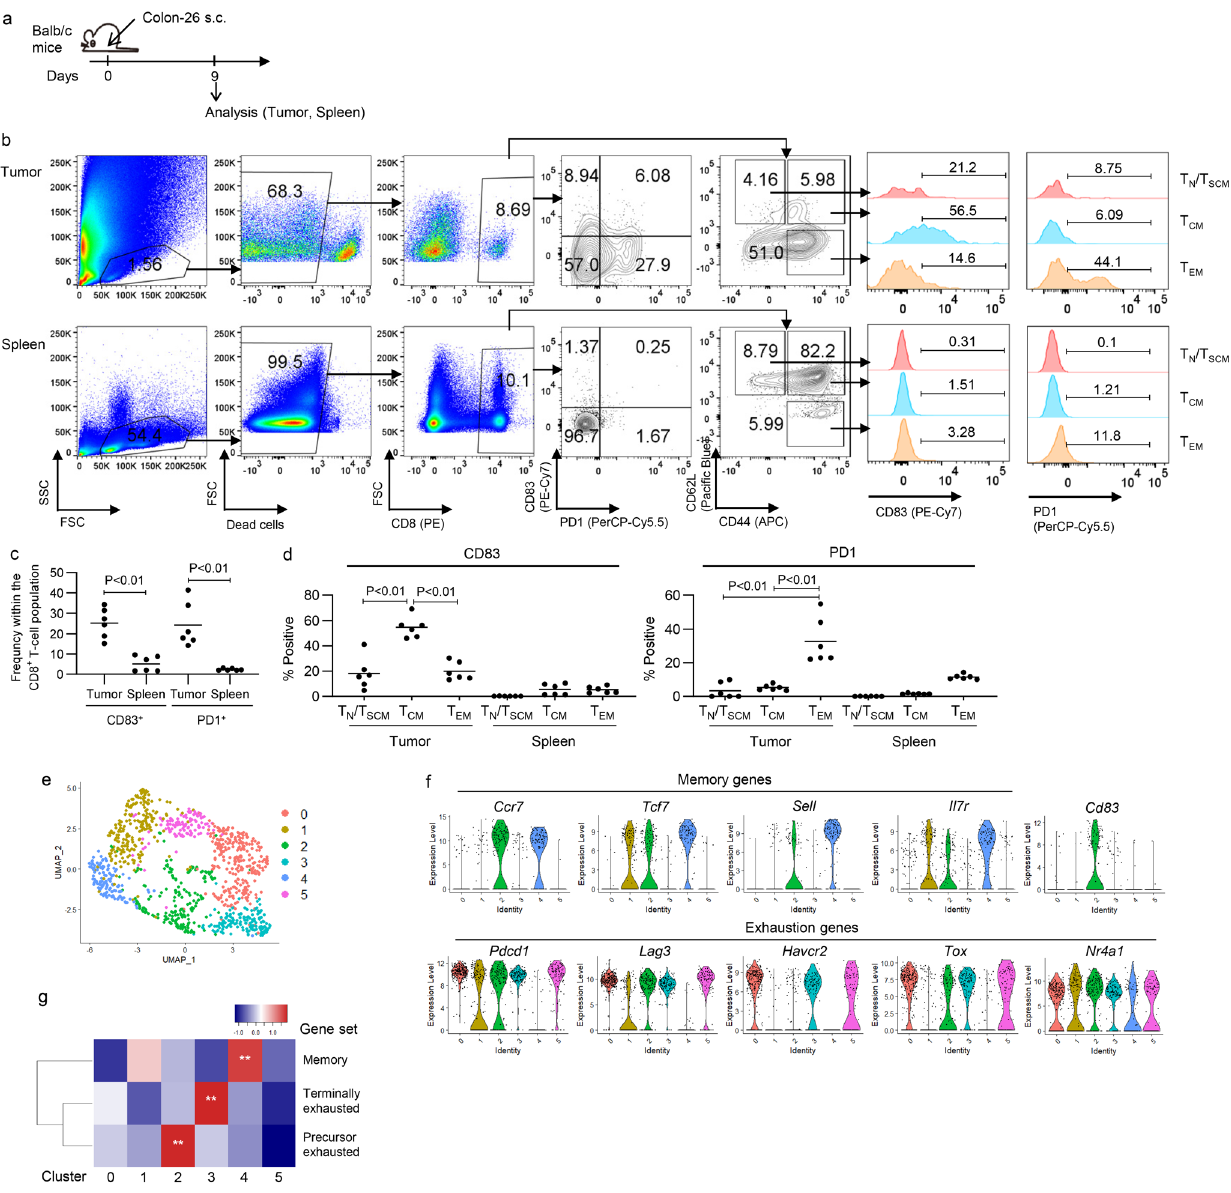
subcutaneously injected with the Colon-26 cell line. Tumor-in fi ltrating T cells (TILs) were analyzed for CD83, PD1, and memory markers (CD44